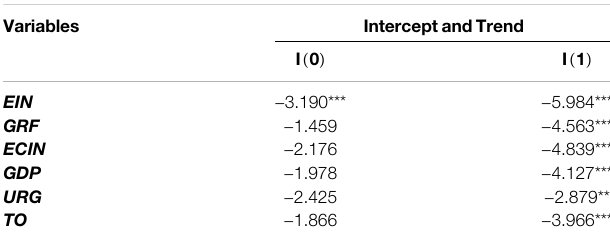
TABLE 5 | Unit root testing (Pesaran, 2007).